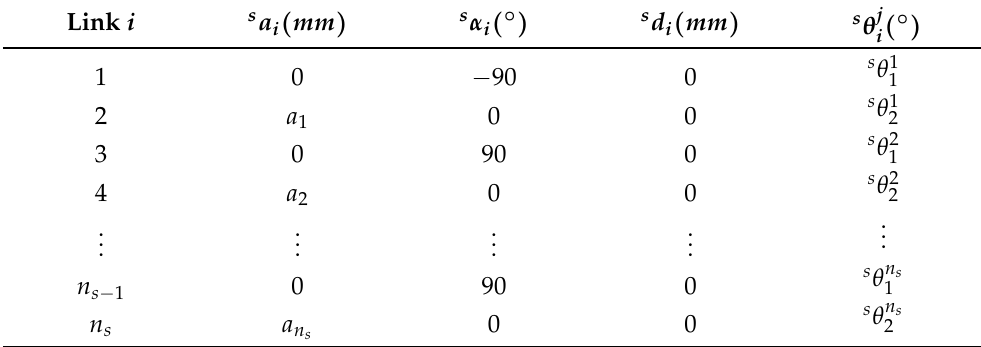
Figure 4. Definition of the joint coordinate system. Table 1. DH parameter table of the